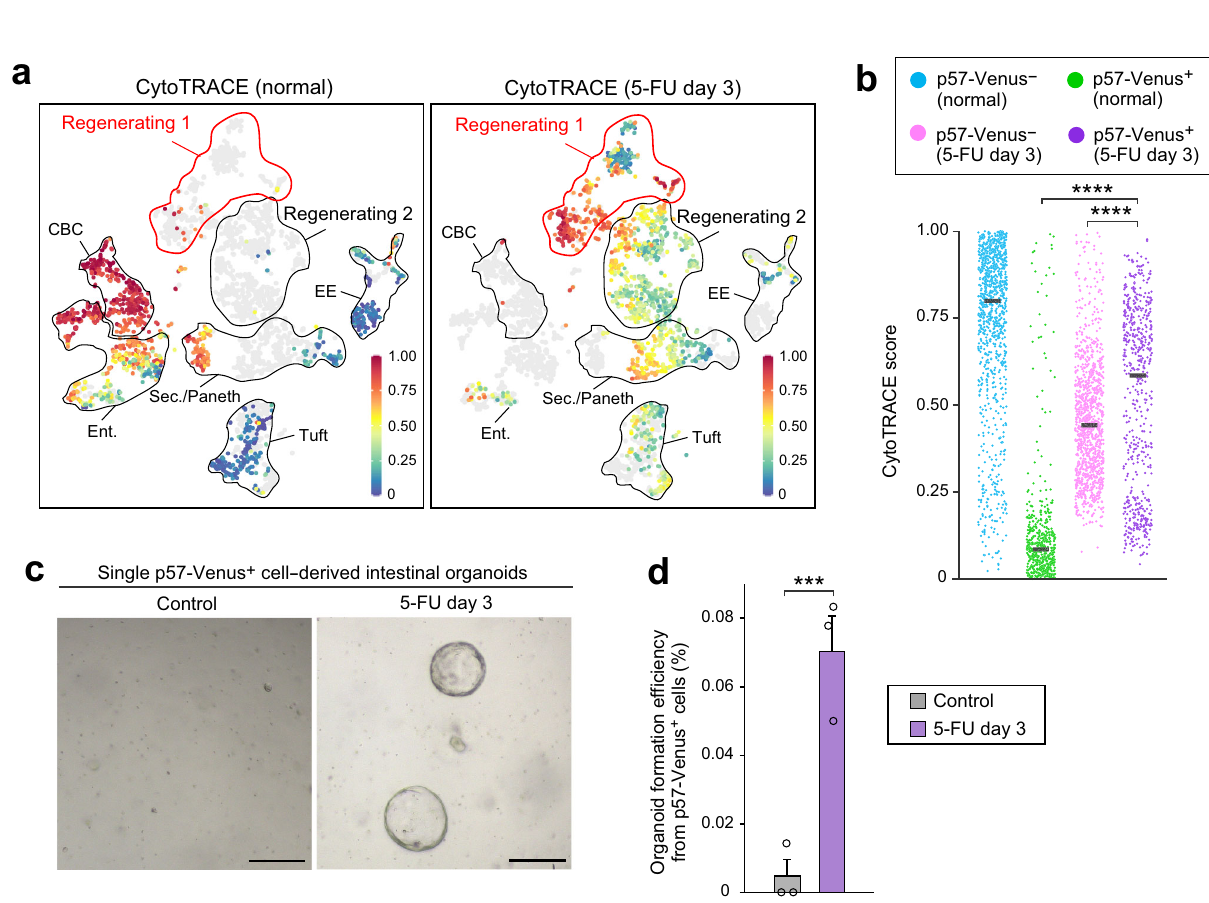
Fig. 6 p57 + cells acquire a stem cell-like transcriptomic pro fi le in association with spatiotemporal reprogramming. a CytoTRACE analysis of our scRNA-seq data. The higher the score, the greater the stem cell potential. The calculated CytoTRACE scores for normal or postinjury crypt cells are overlaid separately on the t -SNE projection shown in Fig. 4b. b CytoTRACE score for each cell. Cells are grouped and color coded on the basis of p57- Venus expression status and experimental condition (n = 567 postinjury p57-Venus + cells, 1055 postinjury p57-Venus ‒ cells, 472 normal p57-Venus + cells, and 923 normal p57-Venus ‒ cells from 2 biologically independent replicates). Bars indicate median values. **** P < 0.001 (Steel-Dwass test). c Representative phase-contrast images of sorted p57-Venus + cell-derived organoids at 8 days after plating. Single cells were isolated from p57-DTR- Venus mice at 3 days after intraperitoneal injection of vehicle (left) or 5-FU at 150 mg/kg (right). Scale bars, 100 μ m. d Ef fi ciency of organoid formation from sorted single p57-Venus + cells isolated from p57-DTR-Venus mice as determined at 8 days after plating as in c . Data are means + SEM ( n = 3 mice). *** P < 0.005 (two-tailed Student ’ s t test). Source data are provided as a Source Data fi (Fig. 7a), suggesting that spatiotemporal reprogramming is indeed operative not only in p57 + EE/tuft lineage cells but also in other cell types during postinjury regeneration.